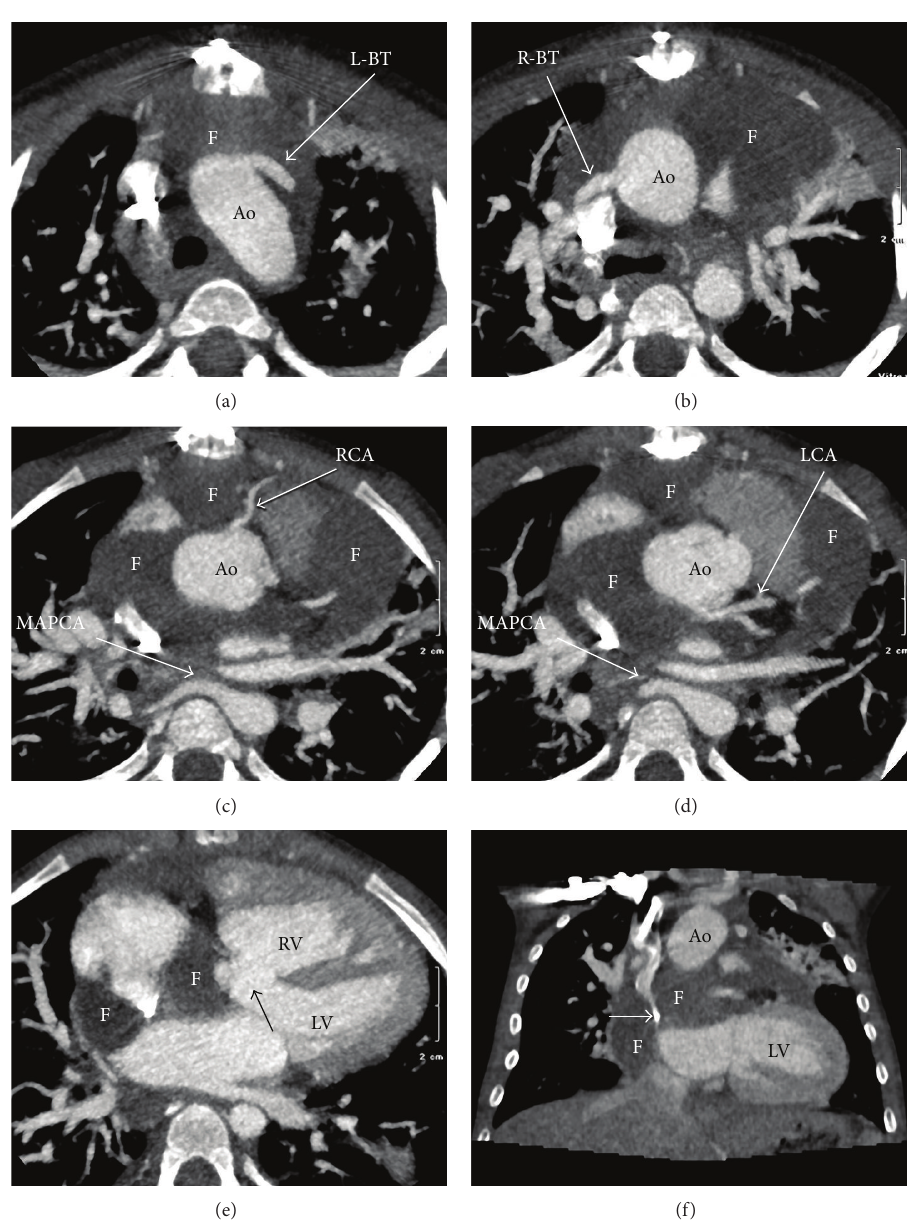
Figure 3: Seroma formation after modified Blalock-Taussig shunt. ECG-triggered volumetric contrast-enhanced cardiac CT (AquilionONE, Toshiba medical systems) is acquired in a single heart beat during systole at a heart rate of 127 beats per minute. Transverse orientation ((a)–(e)) and coronal orientation (f). 3 years old female patient after repair of pulmonary atresia by unifocalization and bilateral modified Blalock-Taussig shunt (BT). Extensive mediastinal fluid (F, all images) in the upper part of mediastinum. Note the excellent image quality showing the left BT shunt (L-BT, (a)) and right-BT shunt (R-BT, (b)), right coronary artery (RCA, (c)), left coronary artery (LCA, (d)), major aorta to pulmonary collateral arteries (MAPCA in c, (d)), and large subaortic ventricular septum defect (black arrow, (e)). The superior vena cava was severely compressed by the mediastinal fluid collection (white arrow, (f)). Ao: aorta; LV: left ventricle; RV: right ventricle. Dose- length product of the CT scan was 20.9 mGy ⋅ cm. Correction factor for chest CT at 100kV for 3 years age was 0.039 mSv ⋅ mGy −1 ⋅ cm −1 ; effective dose 𝐸 was